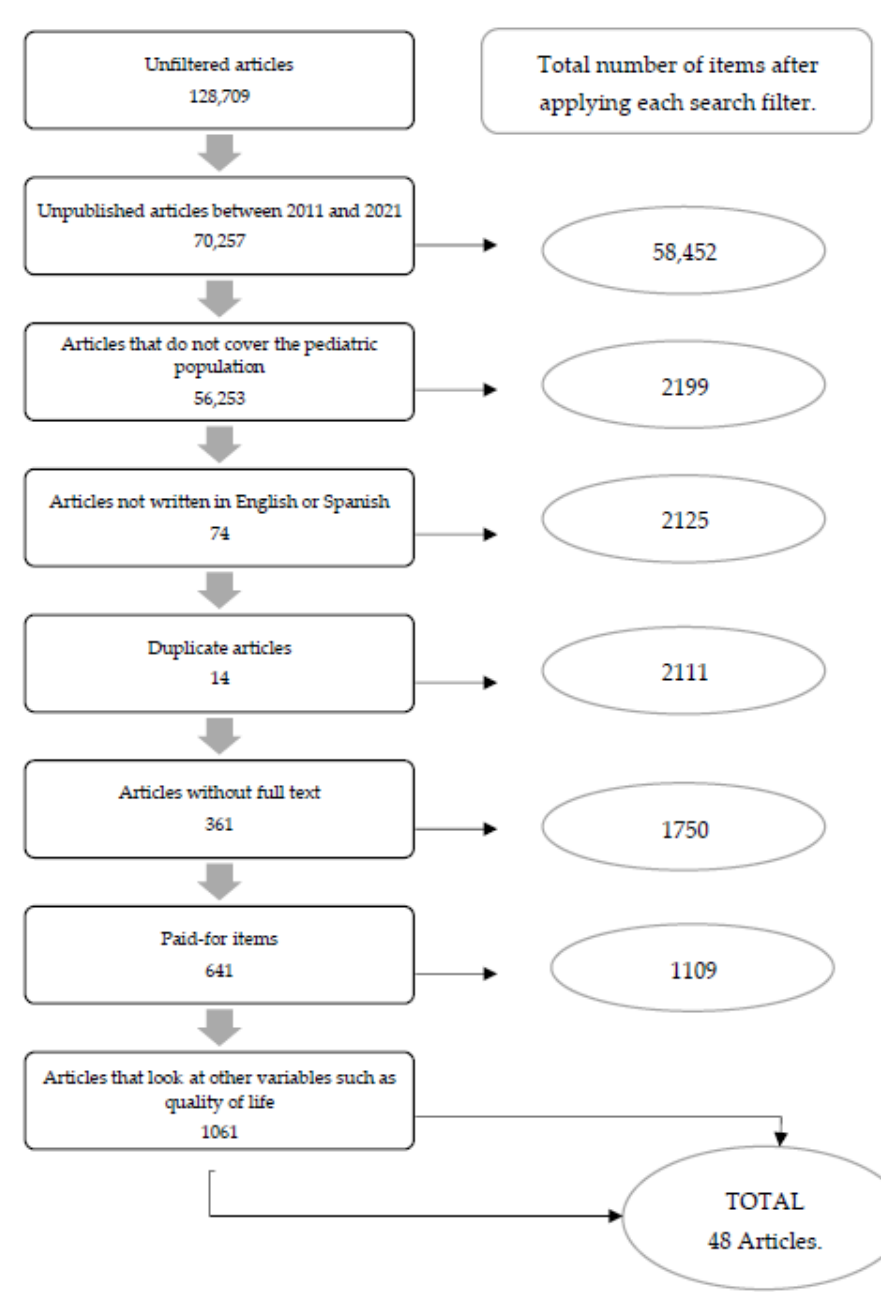
Figure 1. Flow diagram (prepared by the authors).